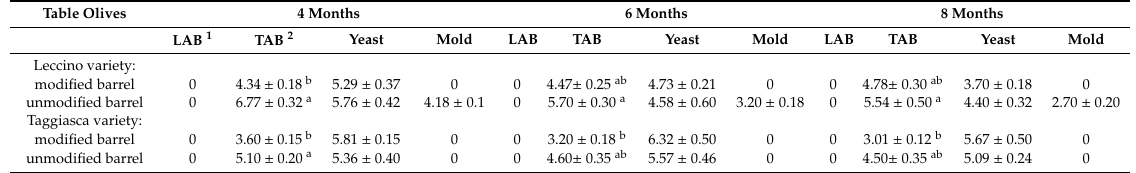
Table 3. Microbiological analysis of the brine from Leccino and Taggiasca black olives processed in two di ff erent types of industrial barrels. TableOlives TAB 2 Yeast Mold LAB TAB Yeast Mold LAB TAB Yeast